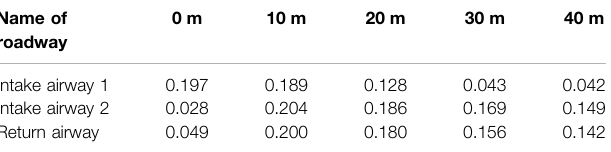
TABLE 2 | Statistical table of attenuation rate of peak overpressure per 10 m in intake airway 1, intake airway 2, and return airway.